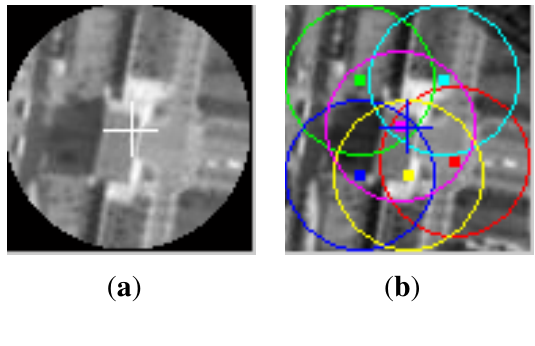
Figure 3. Target templates of the first video. ( a ) template of the OMS, SOAMST and SMS; ( b ) subtemplates distribution of the proposed